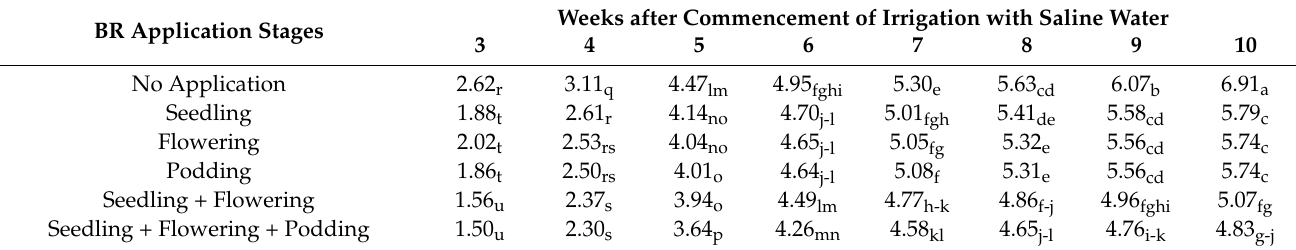
Table 4. Interaction effects of growth stages of 24-epibrassinolide application (BR) and weeks after commencement of irrigation with saline water (WAST) on electrical conductivity of the saturated soil extracts (EC se s) in soybean